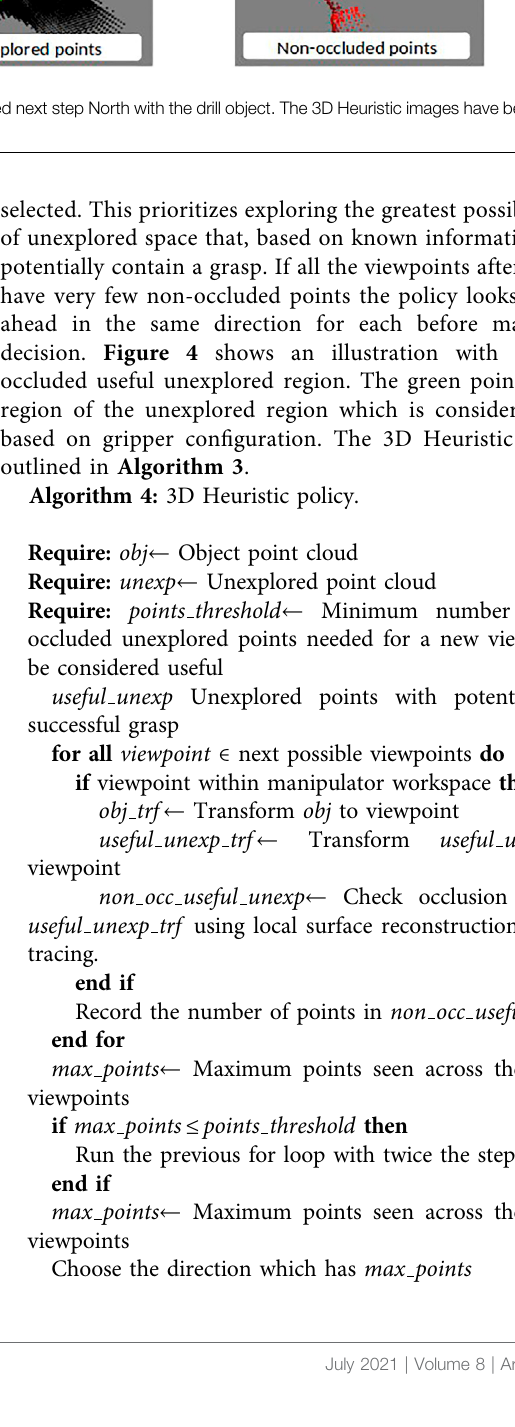
Frontiers in Robotics and AI |